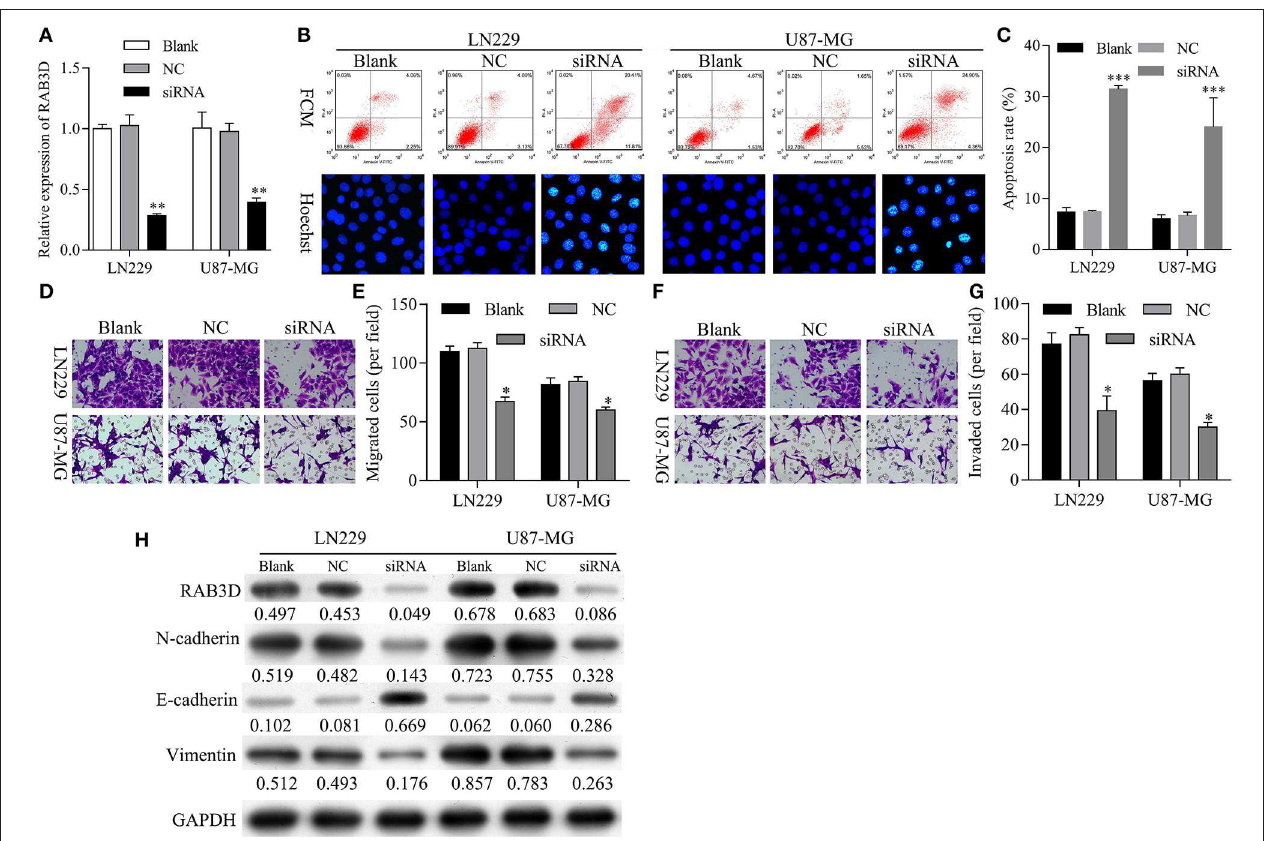
FIGURE 8 | Knockdown of RAB3D facilitated glioma cell apoptosis and inhibited glioma cell migration, invasion, and EMT. (A) RAB3D expression in LN229 and U87-MG cells was inhibited by transfection with RAB3D siRNA, and the efficiency of RAB3D knockdown was evaluated by qRT-PCR assays (* P < 0.05, ** P < 0.01, *** P < 0.001). (B,C) Cell apoptosis in RAB3D-silenced LN229 and U87-MG cells was examined by flow cytometry and Hoechst 33258 staining. (D–G) The migration and invasion capabilities of LN229 and U87-MG cells with RAB3D knockdown were assessed by Transwell assays. (H) The levels of E-cadherin, N-cadherin,